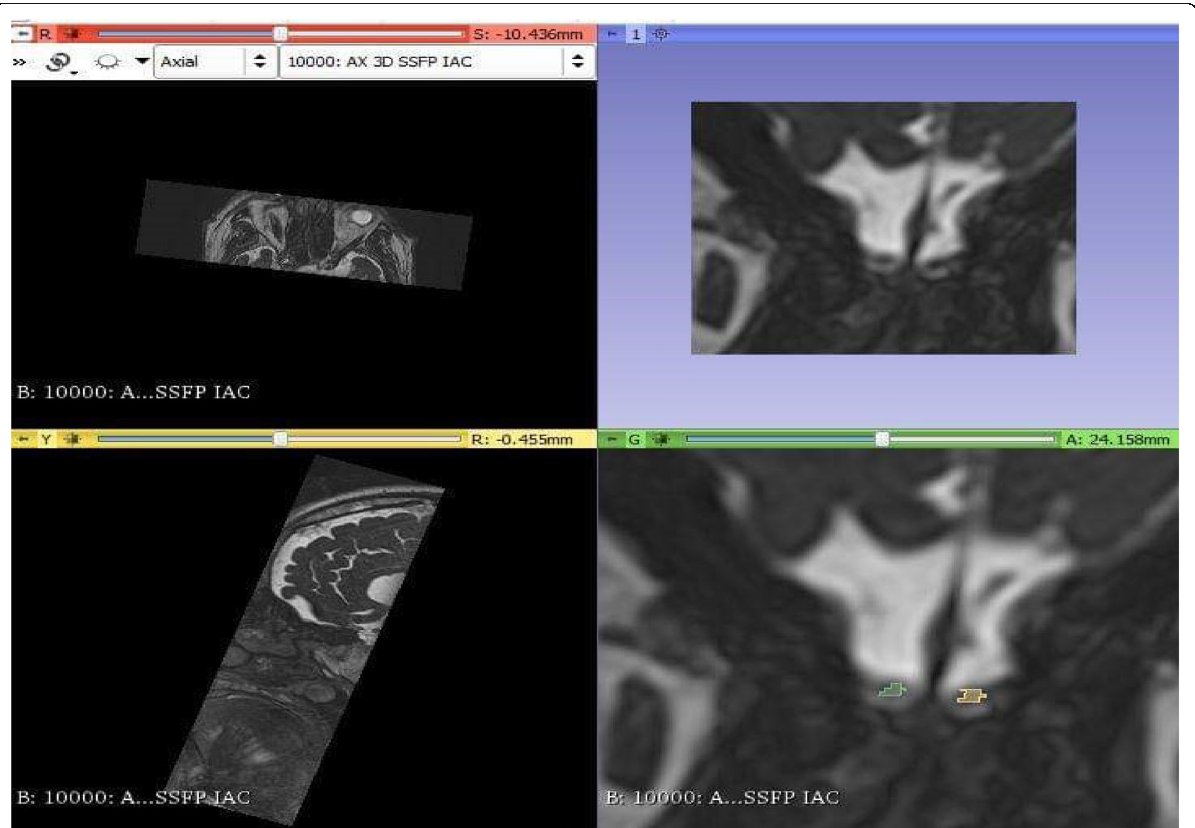
Fig. 2 Three-dimension T2-weighted steady state free precession olfactory bulb volumetry showing right and left olfactory bulbs volumes of 27.1 and 29.8 mm 3